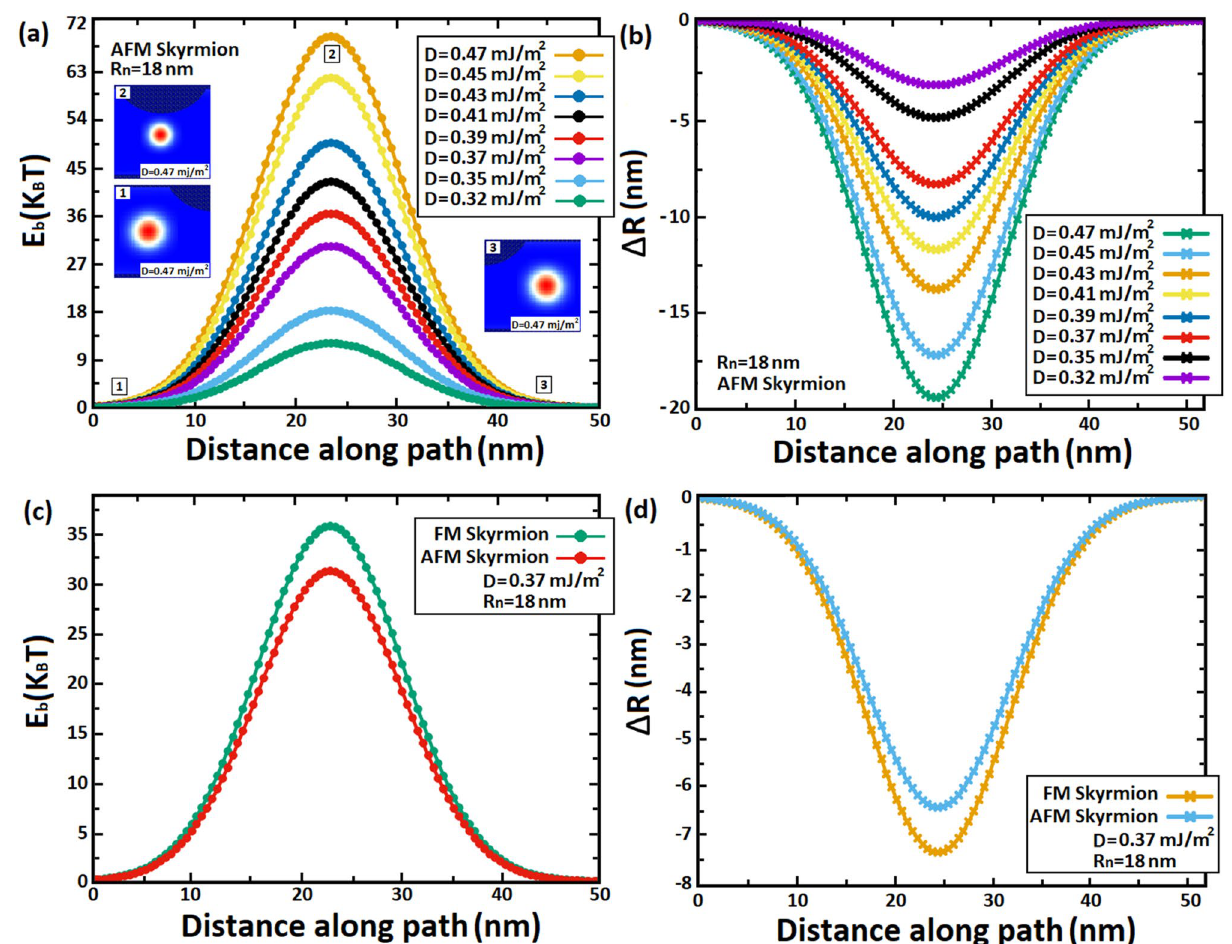
Figure. 10. ( a,c ) Variations of the energy barrier (E b ) in the notch region for AFM and FM skyrmions with various skyrmion sizes R sk in a racetrack memory notched with a fixed notch size of R n 50 nm. ( b,d ) Shrinkage of skyrmions (∆R sk ) along the notch width ( W n